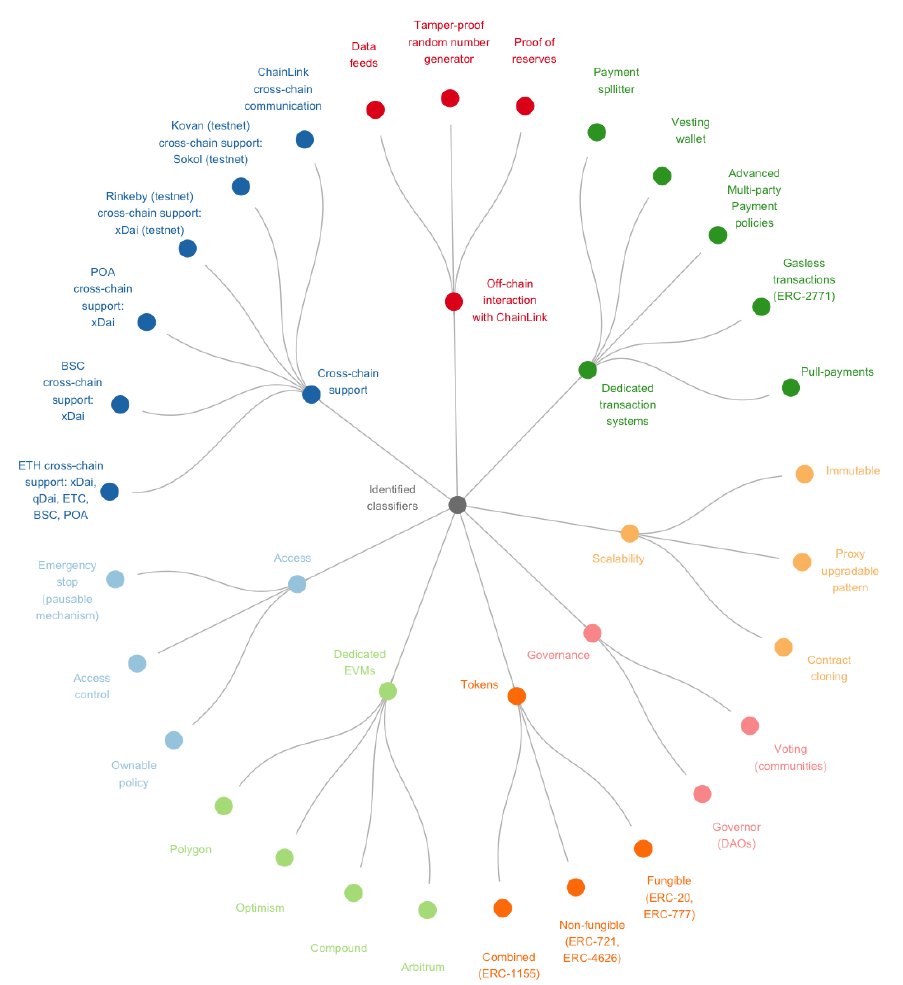
Figure 5. Identified classifiers represented into two levels: (i) main and (ii) detailed